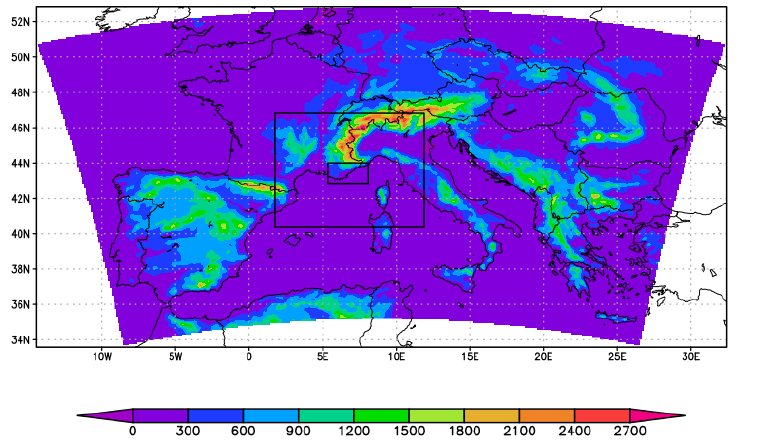
Figure 6. Topography (m) of the outermost Weather Research and Forecasting (WRF) computational domain (10 km resolution) and location of the two nested domains over western Alps and central Mediterranean basin (larger box, 3.3 km resolution) and the Côte d’Azur region (smaller box, 1.1 km